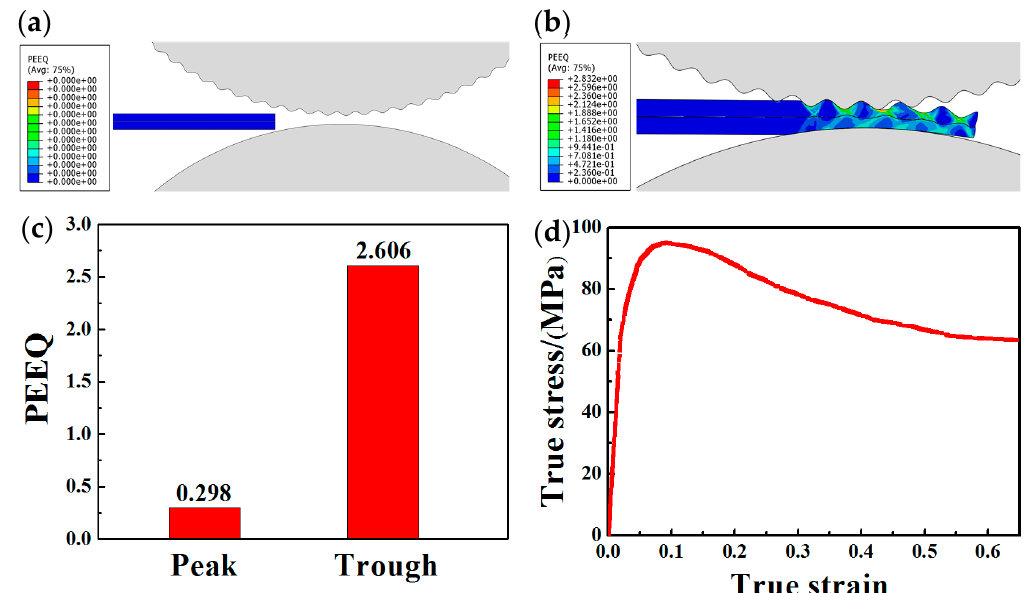
Figure 5. Numerical simulation results of the first CFR pass: ( a ) PEEQ nephogram in the initial stage of rolling; ( b ) PEEQ nephogram during the first corrugated roll process; ( c ) PEEQ histogram; and ( d ) the true stress-strain curve of AZ31B under 5 s − 1 strain rate at 400 °C.